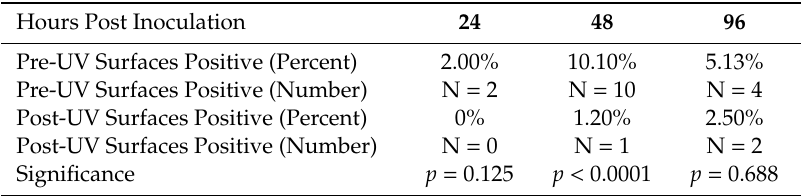
Table 2. Percent of Surfaces Bays Contaminated with Mosaic Virus at Sequential